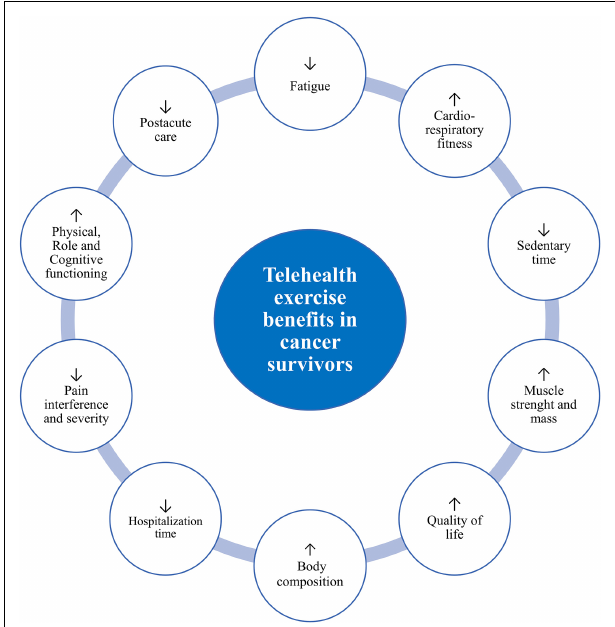
FIGURE 2 | Potential telehealth exercise benefits in cancer patients and survivors. Exercise training can be an effective intervention for attenuating treatment and treatment-related cardiovascular disease